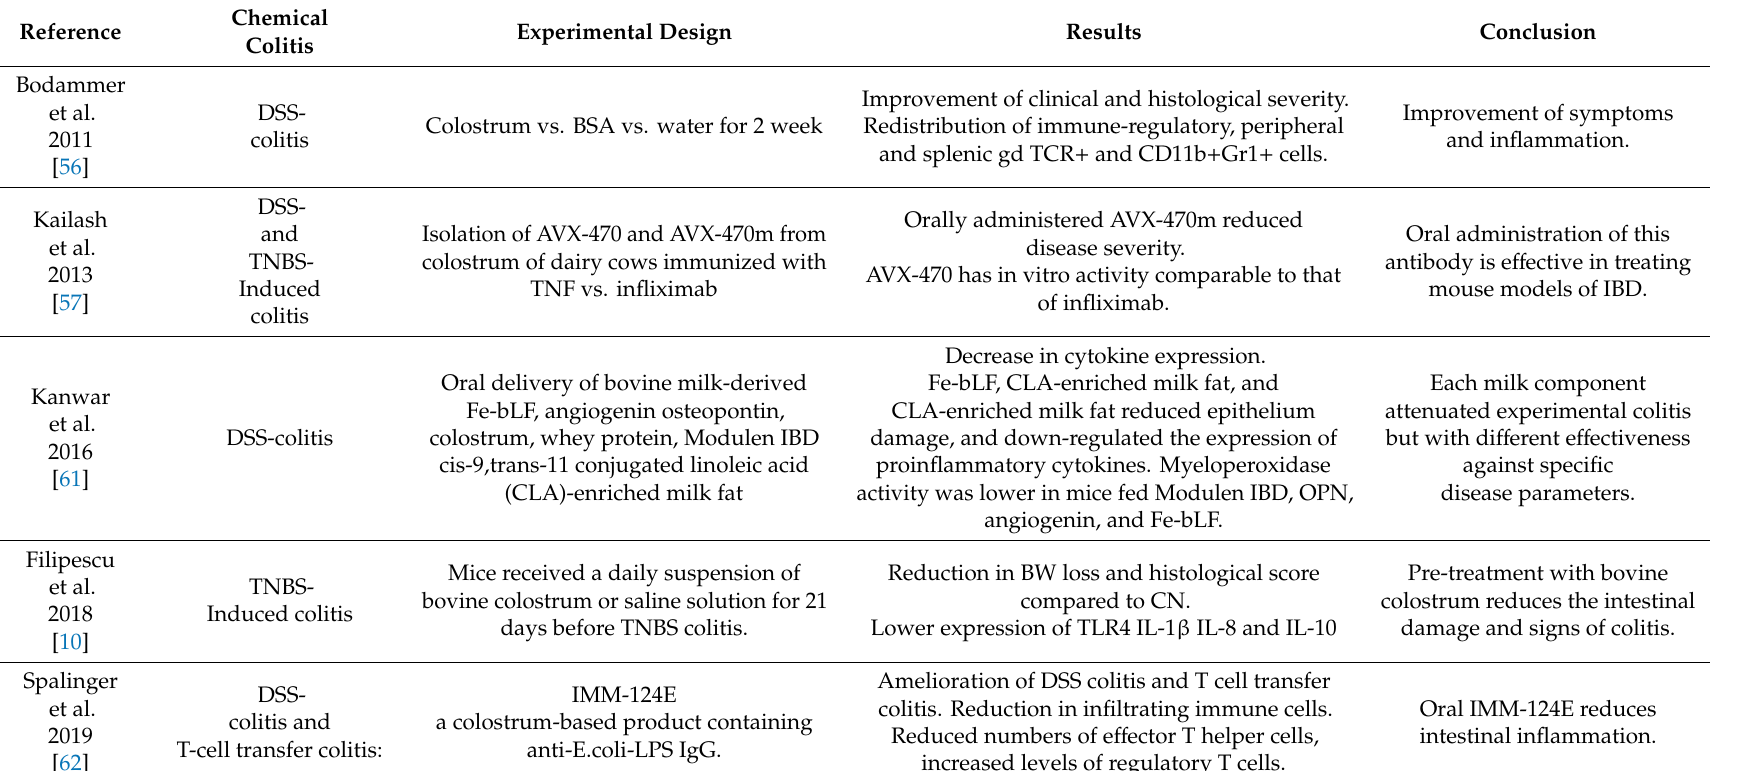
Table 2. Studies on the role of colostrum in experimental